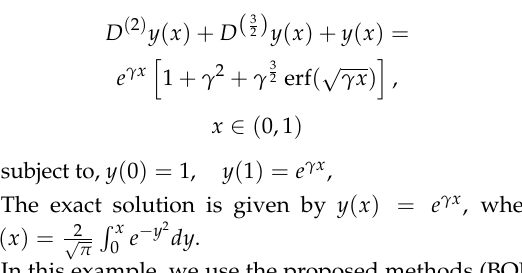
(cid:12) (cid:12) y exact − y approximate